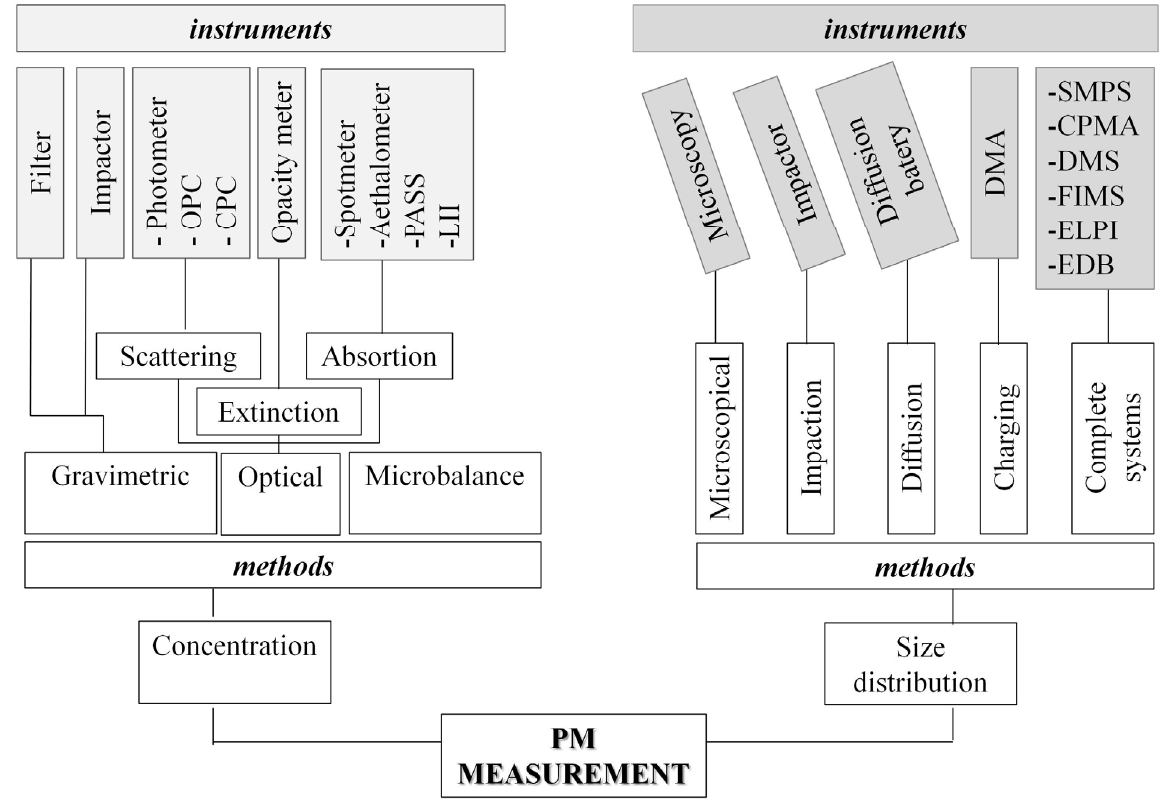
Figure 1. Methods and instruments for PM